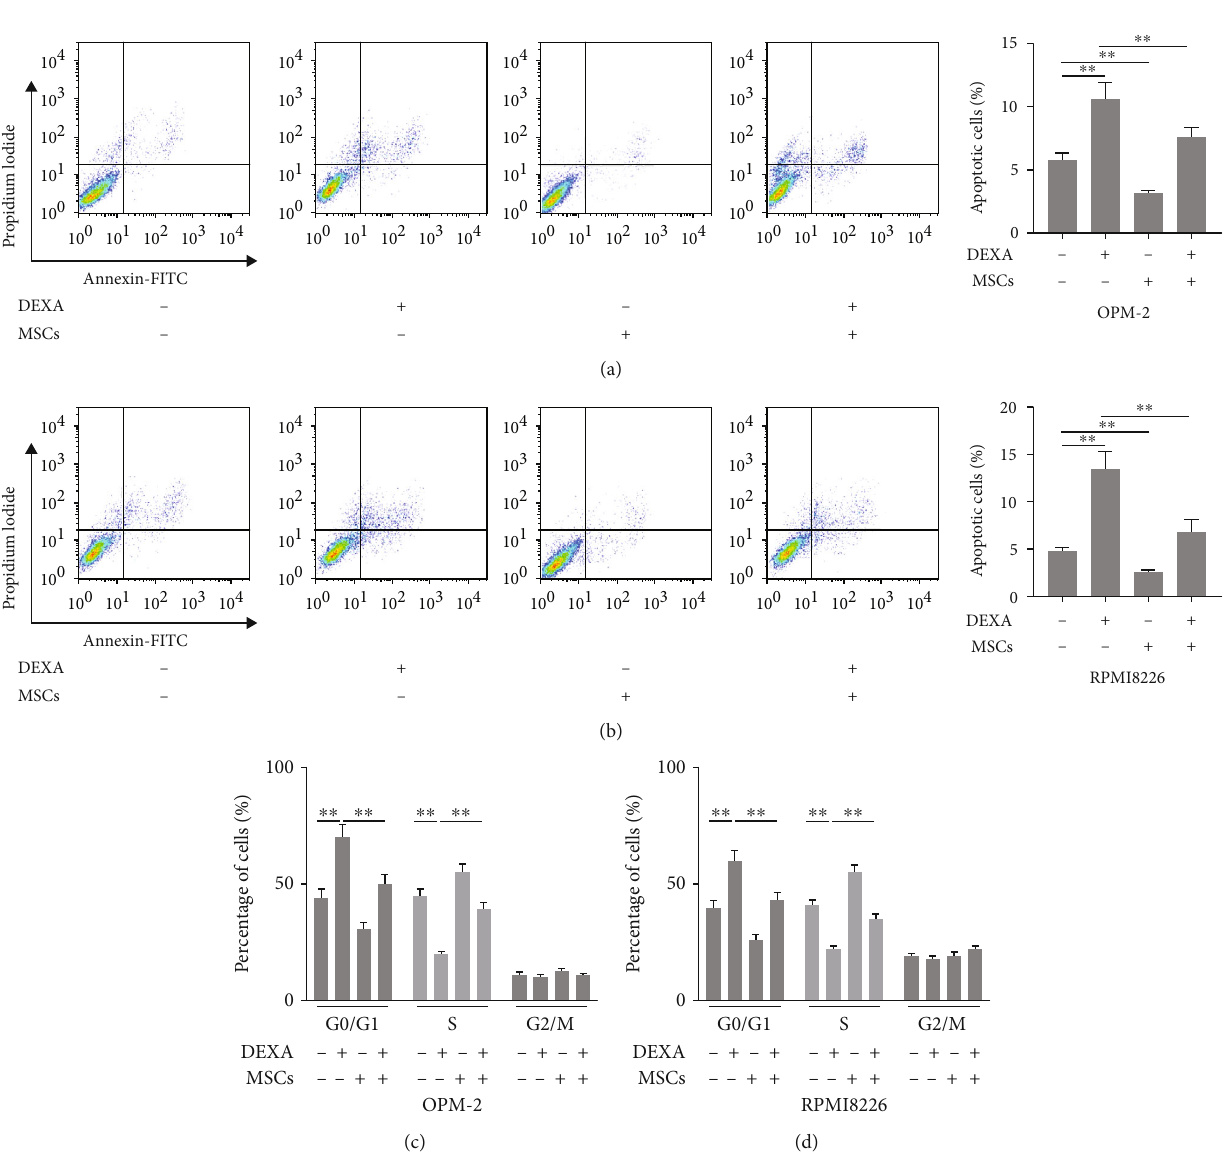
Figure 2: The presence of MSCs regulated the e ff ects of dexamethasone on cell apoptosis and cell cycle distribution. (a, b) The OPM-2 or RPMI8226 cells were cocultured with MSCs in a 6-well transwell microplate with or without dexamethasone (10 μ M). After 48 hours, cell apoptosis assay was determined by using fl ow cytometry. Besides, (c, d) cell cycle distribution was also determined by using fl ow cytometry assay. One-way ANOVA. ∗∗ p < 0 : 01 and ∗∗∗ p < 0 : 001